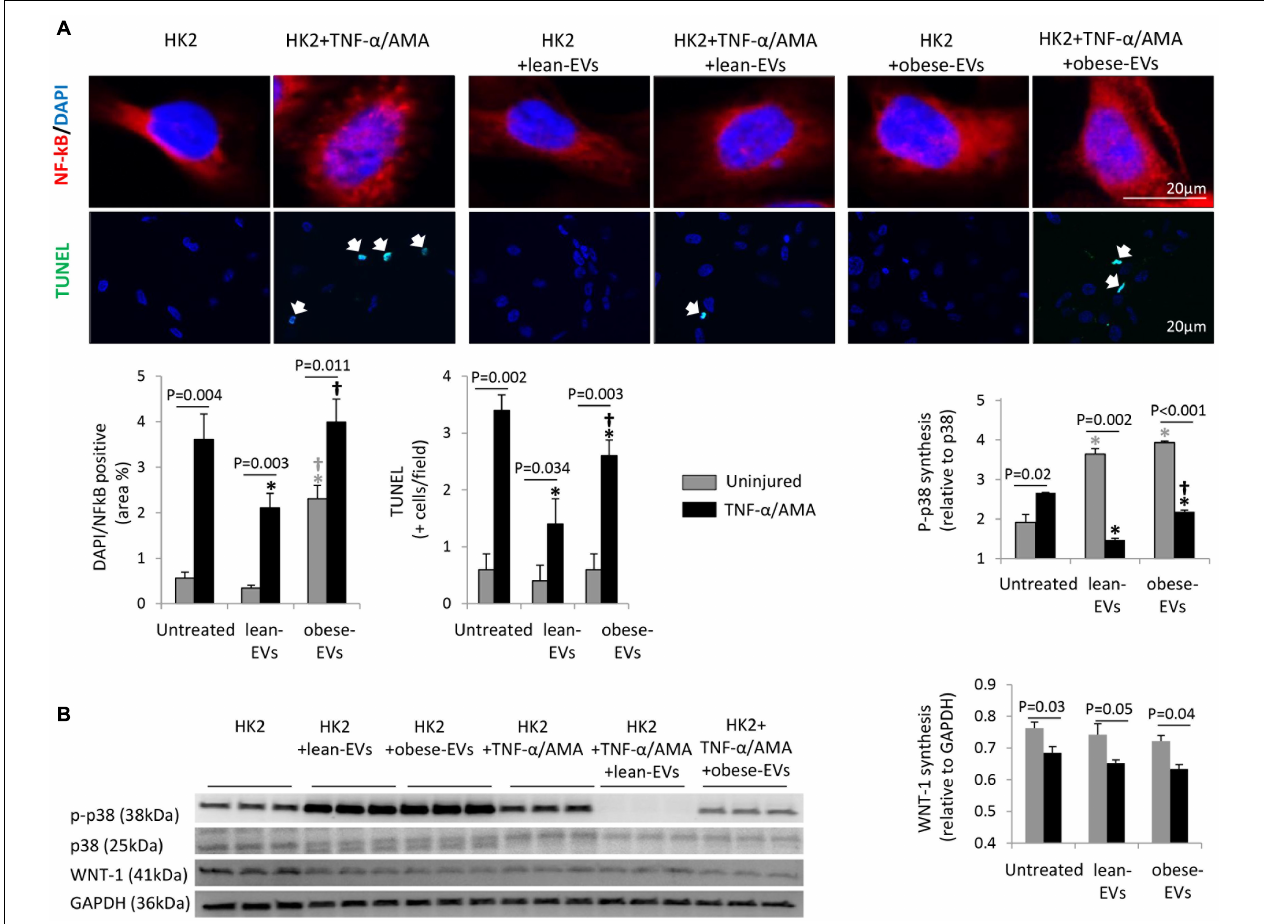
FIGURE 5 | Effects of lean- and obese-EVs on pathways detected in RNA sequencing. Representative immunofluorescence staining of HK2 cells with NFk-B/DAPI and TUNEL, and quantification of NFk-B/DAPI co-localization and the number of TUNEL + cells (A) (Student’s t -test). HK2 cells were co-incubated with 10 ng/ml TNF- α and 10 µ M AMA for 24 h and subsequently treated with human lean- or obese-EVs. Western blot quantification of p-p38 and WNT-1 synthesis in study groups (B) (Student’s t -test). ∗ p < 0.05 vs. HK2, † p < 0.05 vs. HK2 +